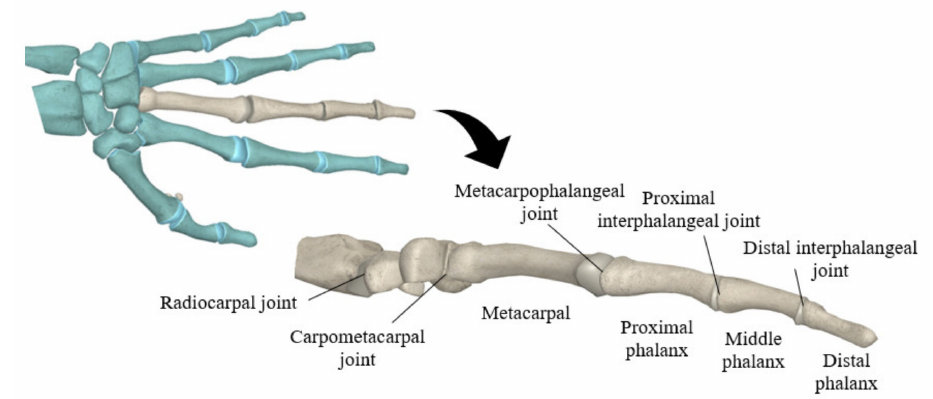
Figure 1. Bones and joints of the